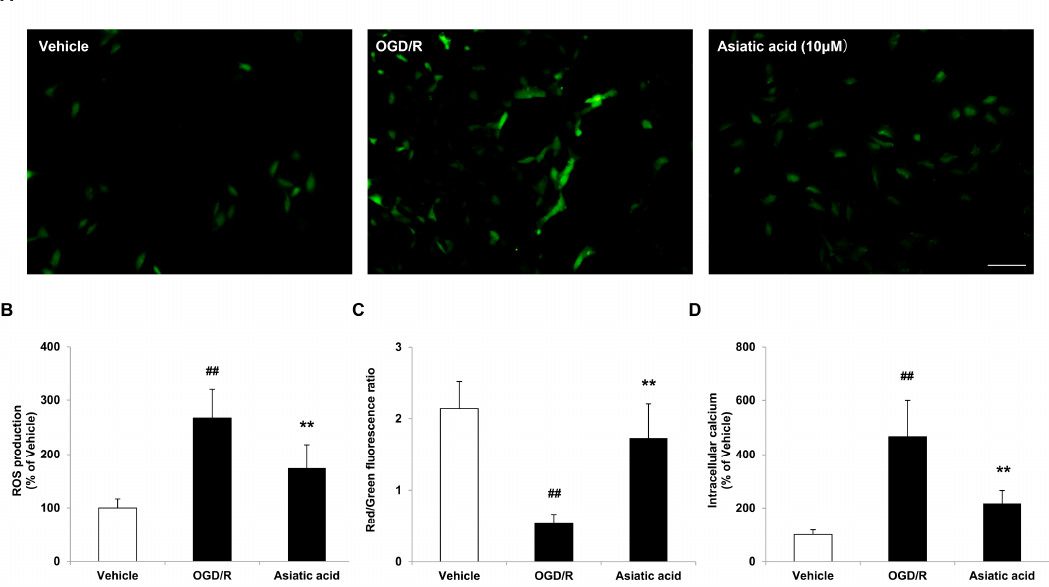
Figure 3. Asiatic acid prevents mitochondrial dysfunction following oxygen-glucose deprivation/ reoxygenation (OGD/R) injury. ( A ) Reactive oxygen species (ROS) production as visualized by dichlorofluorescein (DCF) fluorescence; ( B ) Quantitative analysis of ROS production by measurement of fluorescence intensity with a microplate reader; ( C ) Measurement of mitochondrial membrane potential with JC-1-fluorescent dye; ( D ) Determination of intracellular calcium by Fluo-3 AM. ## p < 0.01 vs. the vehicle group; ** p < 0.01 vs. the OGD/R group. Scale bar, 100 μ m.